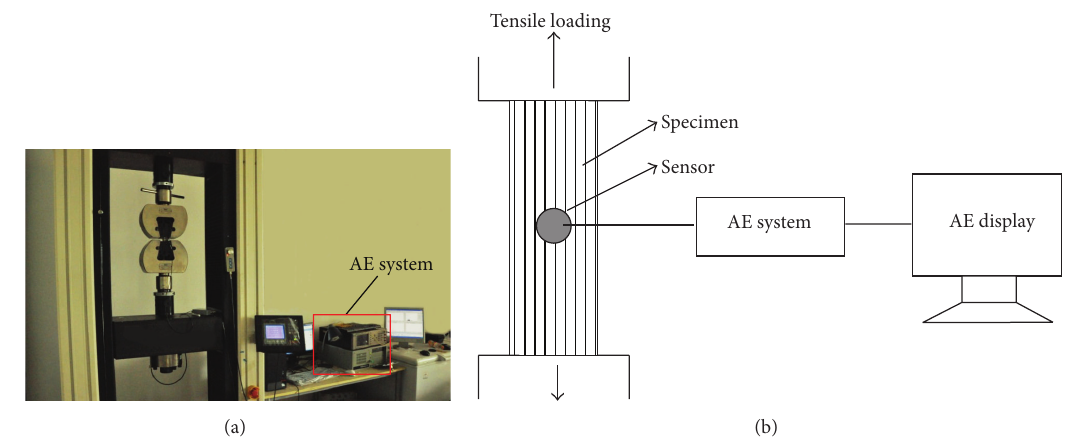
Figure 2: Experiment platform. (a) Experimental equipment; (b) diagram of equipment connection.